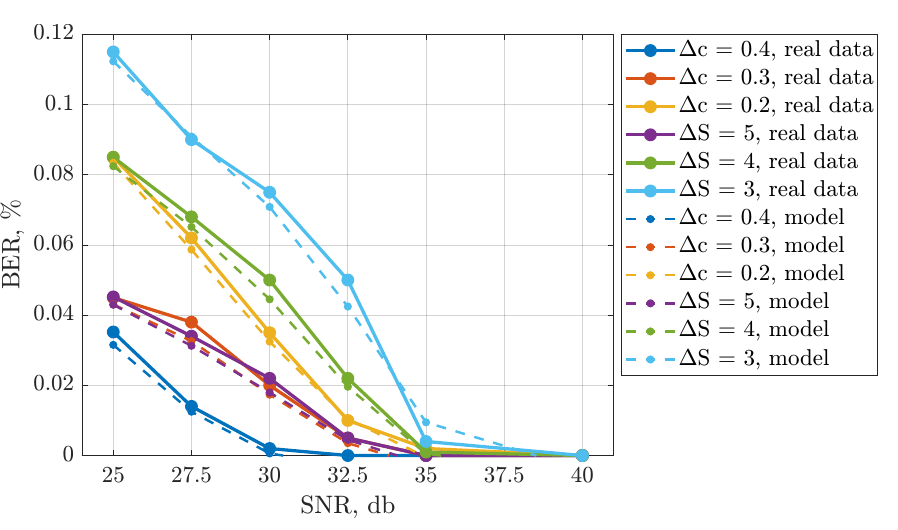
Figure 7. BER vs. SNR